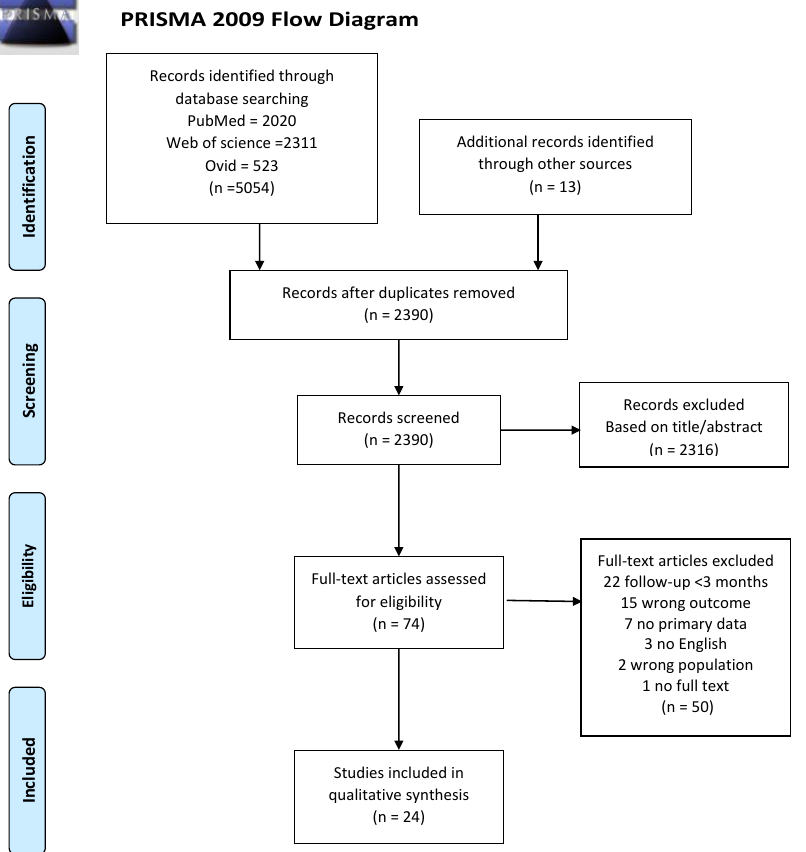
Figure 1. Diagram flow of studies screened and included in the review and meta-analysis.